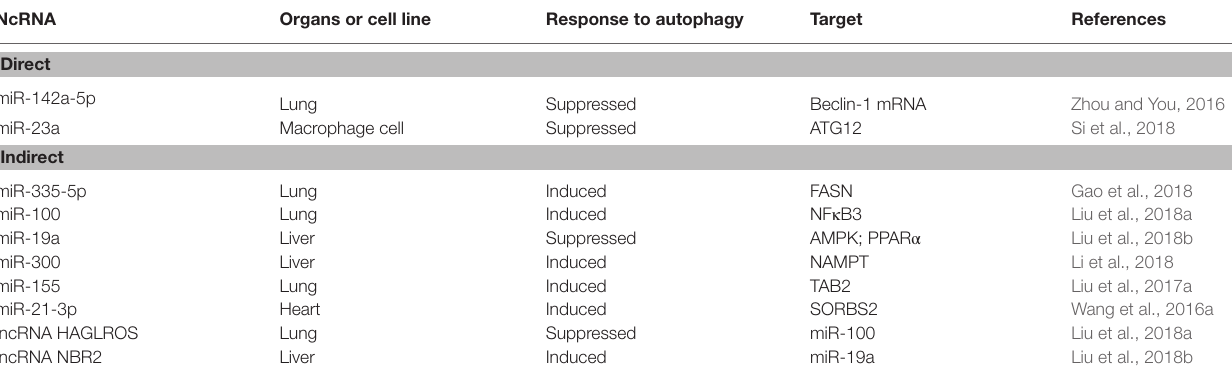
TABLE 1 | Summary of recent studies on non-coding RNAs that directly or indirectly regulate